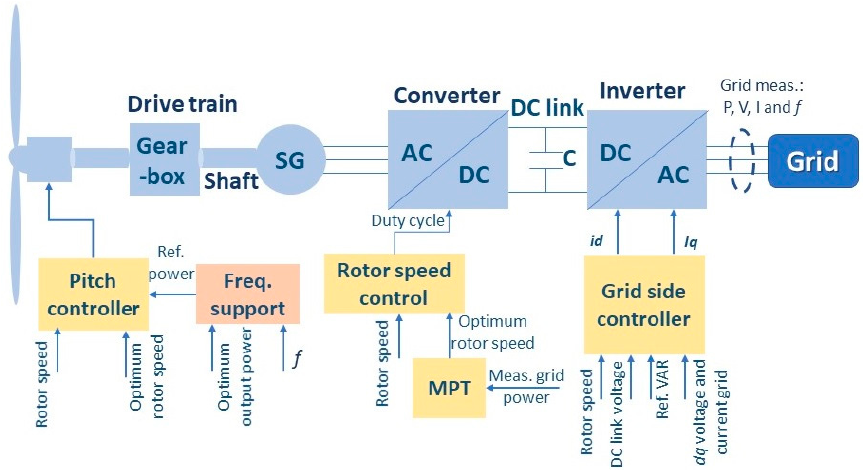
Figure 6. Schematic of the implemented Type 4 WTG and the associated